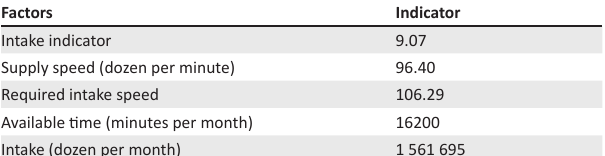
TABLE 11: Intake supply speed.